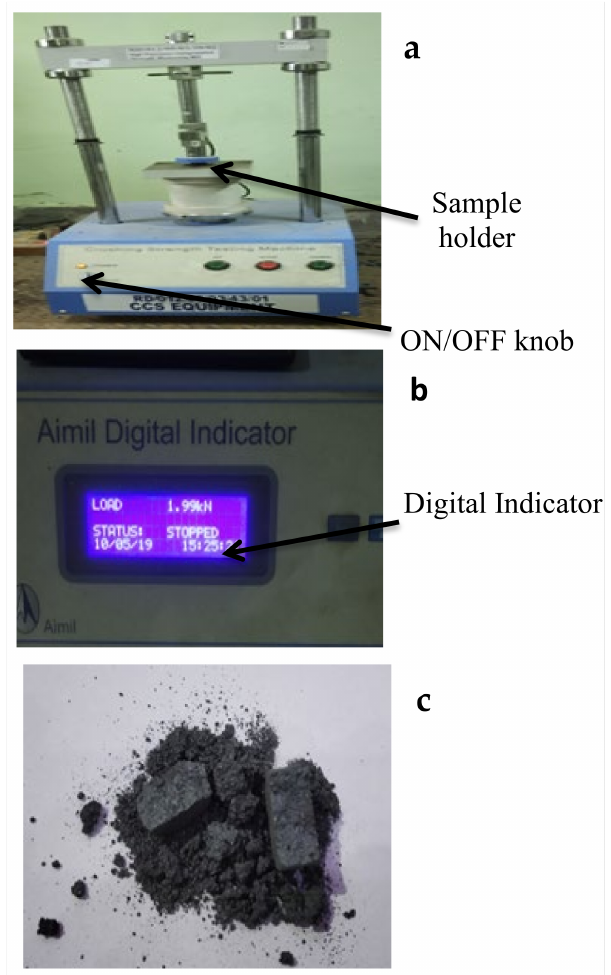
Figure 10. ( a ) CCS Tester, ( b ) digital indicator of CCS Tester, and ( c ) crushed sample after CCS test. The microhardness of the samples was measured using microhardness tester of